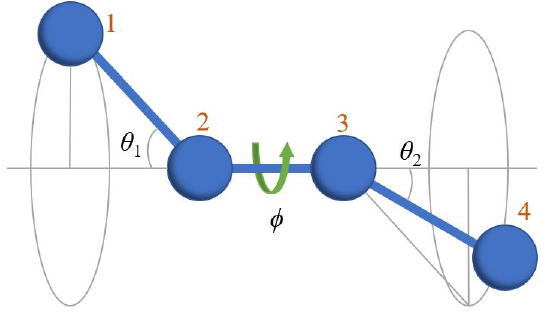
Figure 6. Definition of bending angles θ 1 , θ 2 and torsion angle φ . These angles are also used in the joint orientational functions of bending and torsion angles f bt ( θ 1 , φ , θ 2 ) (see Section 4). The angle φ gives the rotation around the line defined by monomers 2-3 and is measured with respect to the plane defined by the three successive bonds